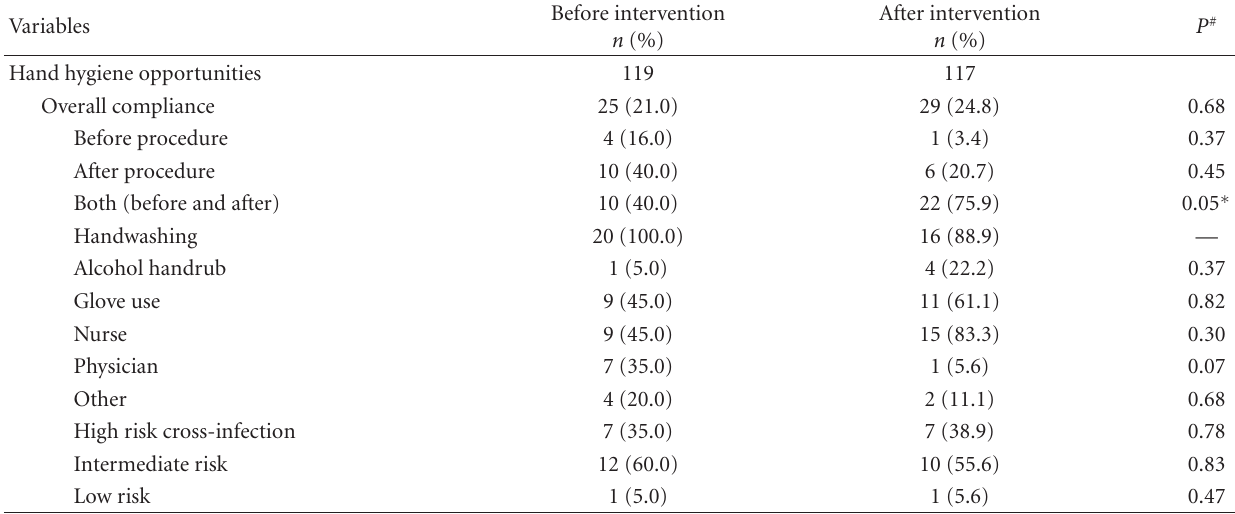
Table 1: Characteristics of opportunities for hand hygiene and compliance before and after intervention.